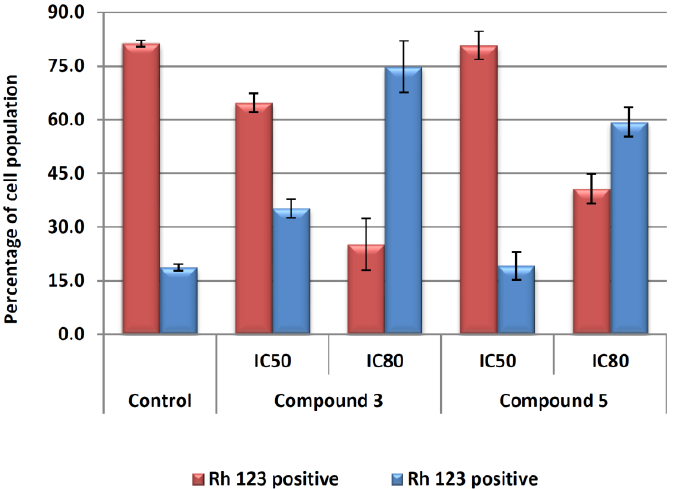
Figure 4. Flow-cytometry analysis of Rh123 staining after exposure of Hep-G2 cells to compounds 4 and 8c for 72 h at IC 50 and IC 80 concentrations. Rh123 positive cells (red bars) and Rh123 negative cells (blue bars) were counted. Values are expressed as means ± S.E.M. of at least two experiments in duplicate.